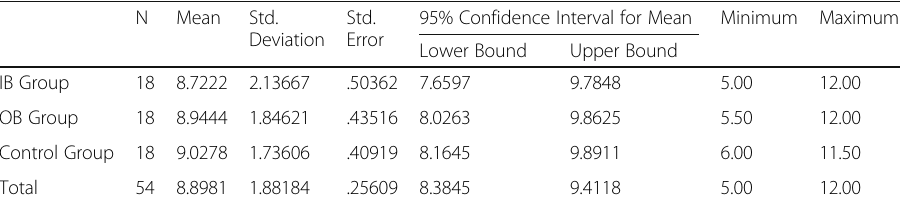
Table 2 Descriptive Statistics (Pre-tests)